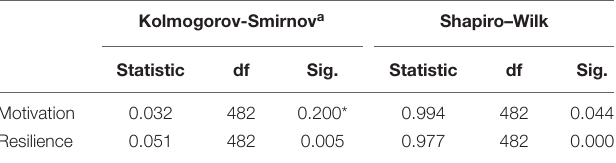
TABLE 2 | Normality Test for questionnaires.